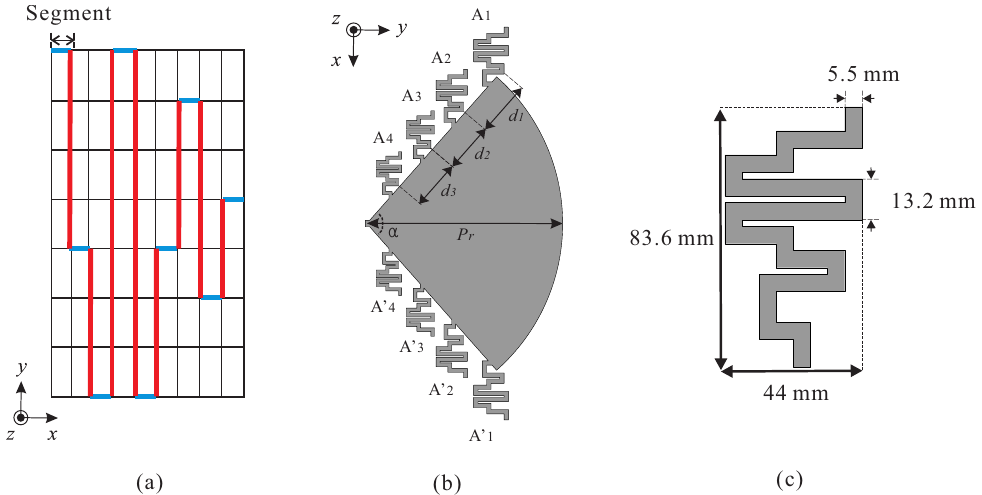
Figure 3. Design concept of the proposed antenna: ( a ) meandered arm; ( b ) circular sector-shaped dipole antenna; ( c ) optimized meandered arm, A 1 .